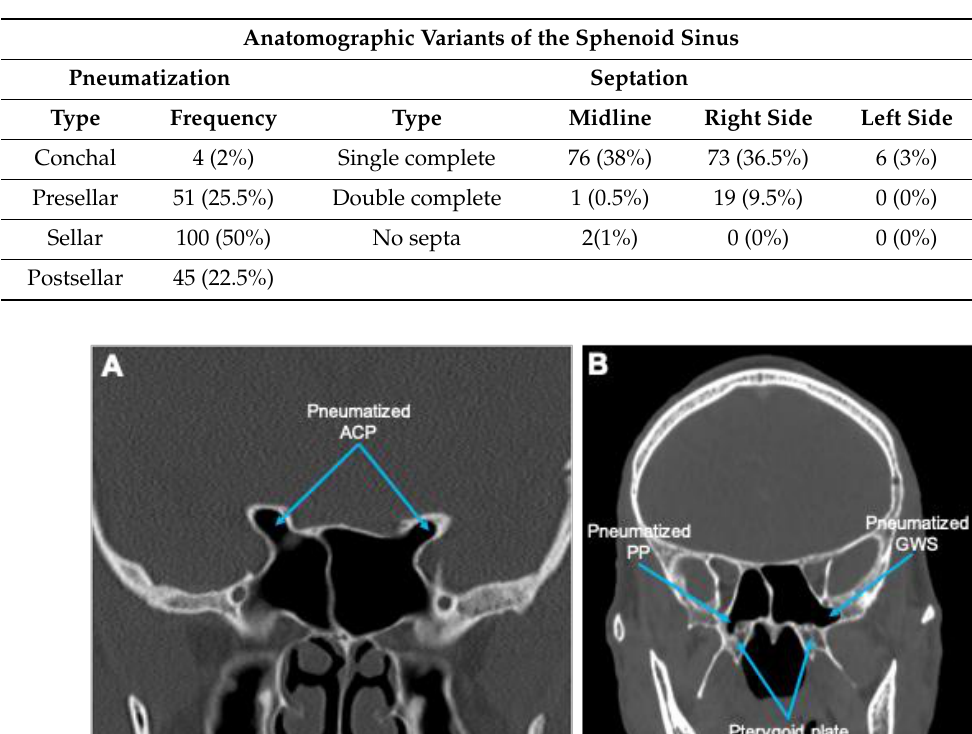
Figure 4. Septation of the sphenoid sinus. Axial CT images showing ( A ) Double inter-sphenoidal septum, ( B ) Right side septal bone, ( C ) Left side septal bone, and ( D ) Right incomplete and left complete septum. Note that almost 90% of the patient population who participated in this study showed single septation, whereas 1% without septation. Image orientation: S, superior; I, inferior; R, right side; L, left side. Table 2. Incidence of sphenoid sinus pneumatization and septation in the Ethiopian population. Anatomographic Variants of the Sphenoid Sinus Pneumatization